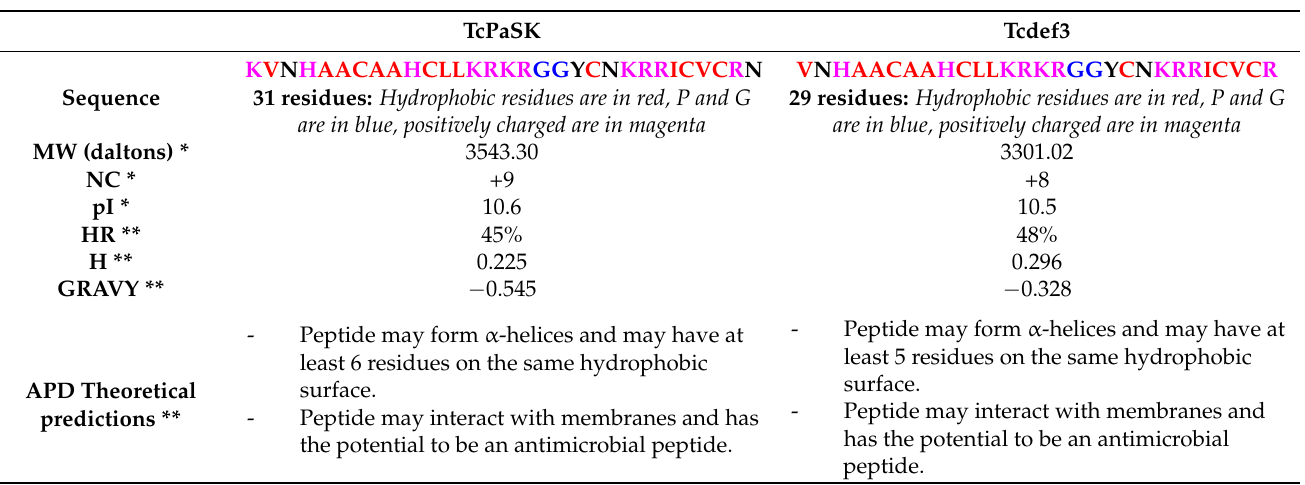
Table 1. Theoretical predictions of the physicochemical parameters of TcPaSK and Tcdef3 peptides. Molecular mass (MW), net charge at pH = 7 (NC) and isoelectric point (pI) values were calculated from * https://www.bachem.com/ service-support/peptide-calculator/. APD defined total hydrophobic ratio (HR), hydrophobicity (H) and Grand Average hydropathy (GRAVY) values were estimated from ** APD3: Antimicrobial Peptide Calculator and Predictor